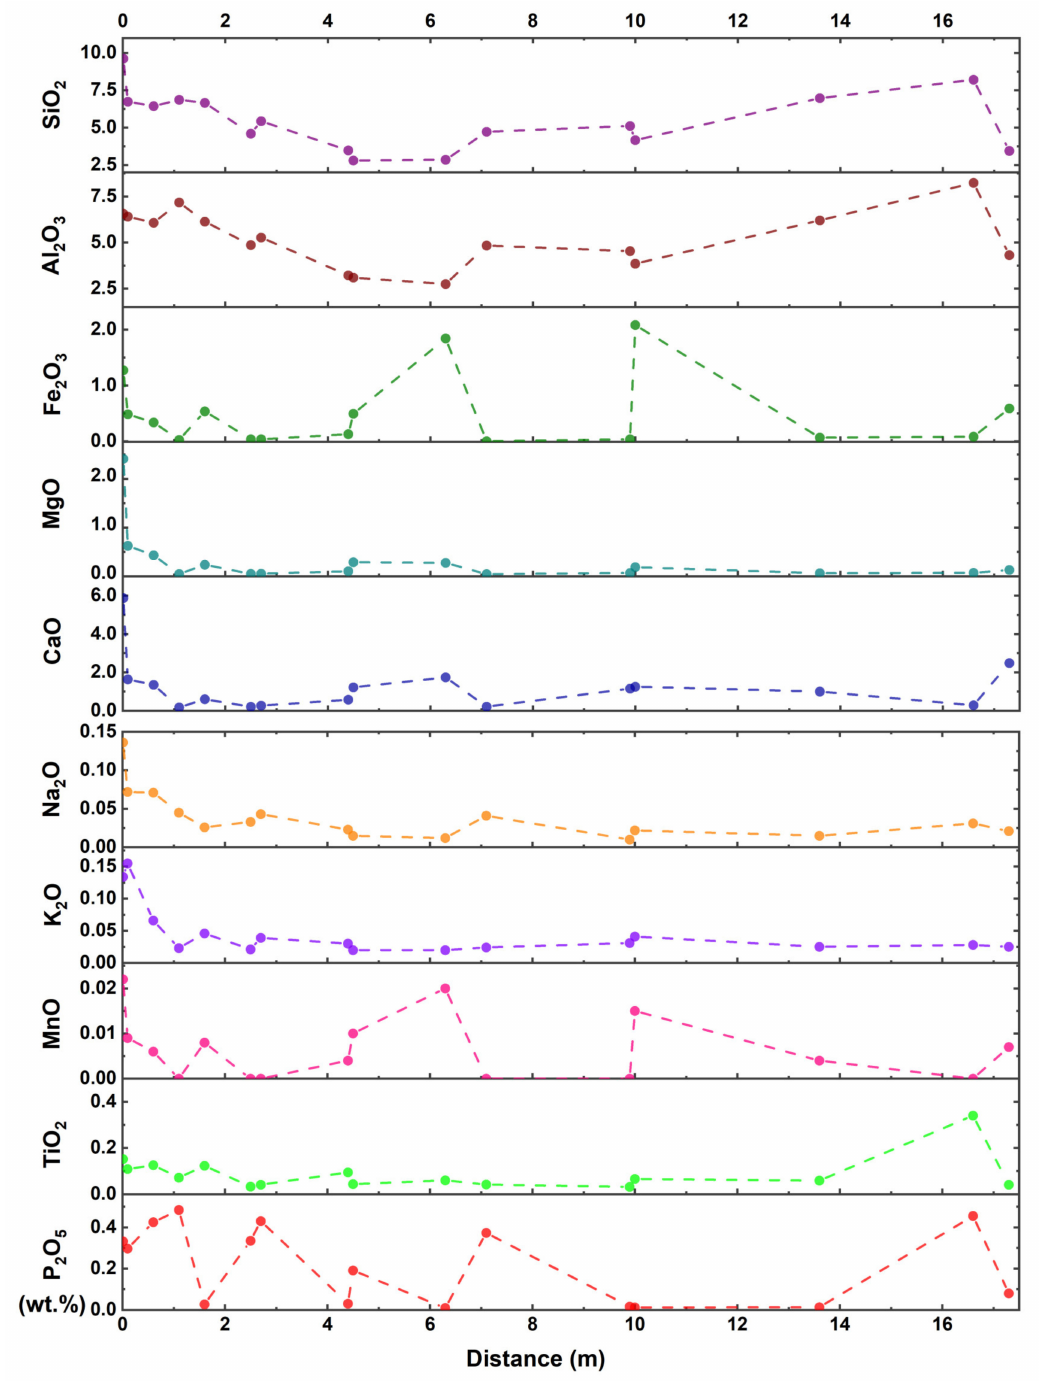
Figure 11. Contents of major element oxides in the Tashan coal versus distance from the